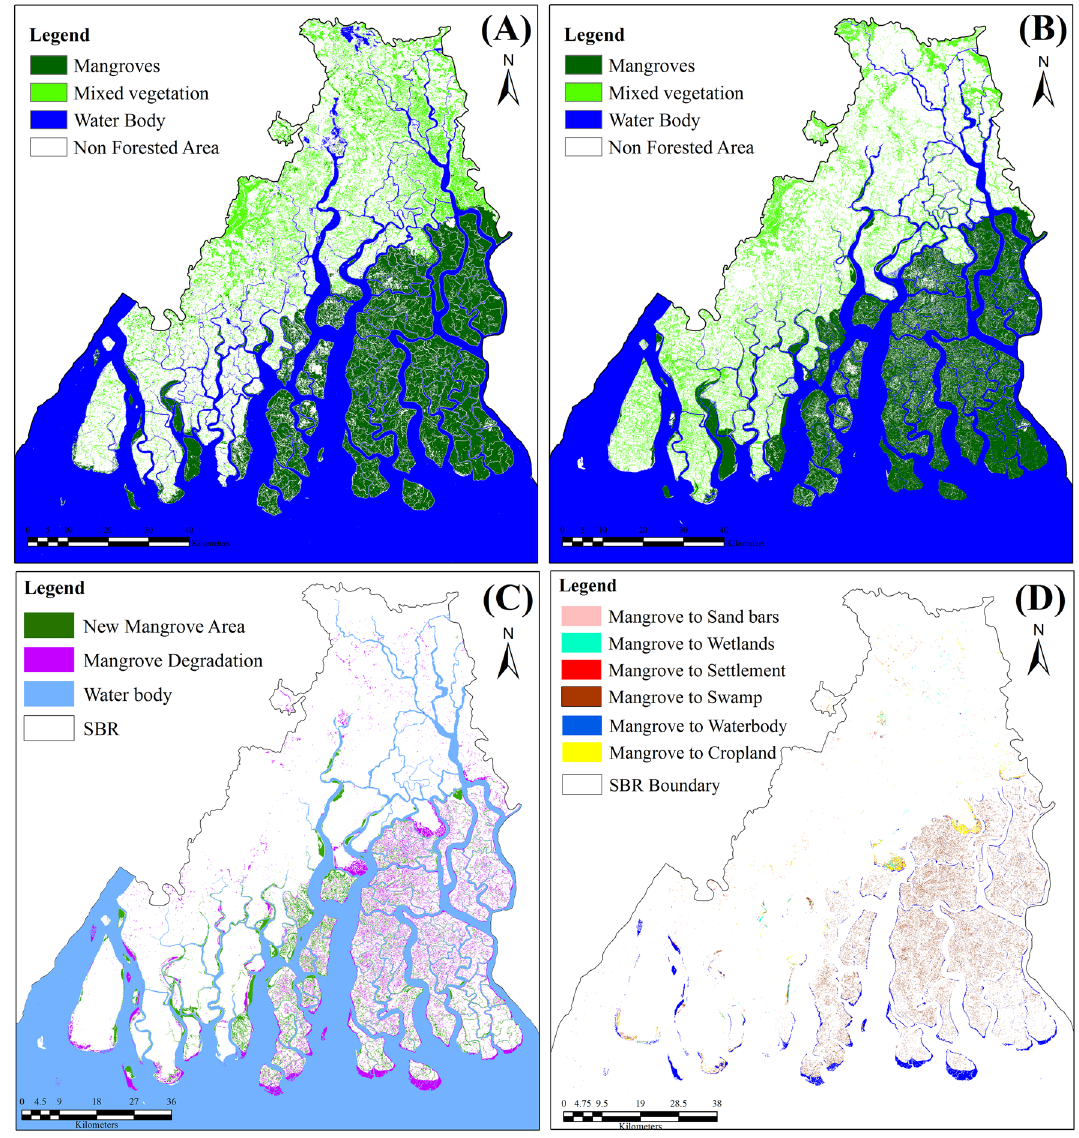
Figure 4. Mangrove cover map of Sundarban Biosphere Reserve during 1975 ( A ) and 2020 ( B ), Mangrove accretion and mangrove degradation over 1975–2020 ( C ) and Nature of mangrove degradation in Sundarban Biosphere Reserve ( D ). (The Landsat satellite images are obtained from the EarthExplorer [https:// earth explo rer. usgs. gov/]. The maps were prepared using ERDAS IMAGINE 2014 [https:// hexag on. com/ produ cts/ erdas- imagi ne] and ArcGIS 10.8.2 software [https:// deskt op. arcgis.